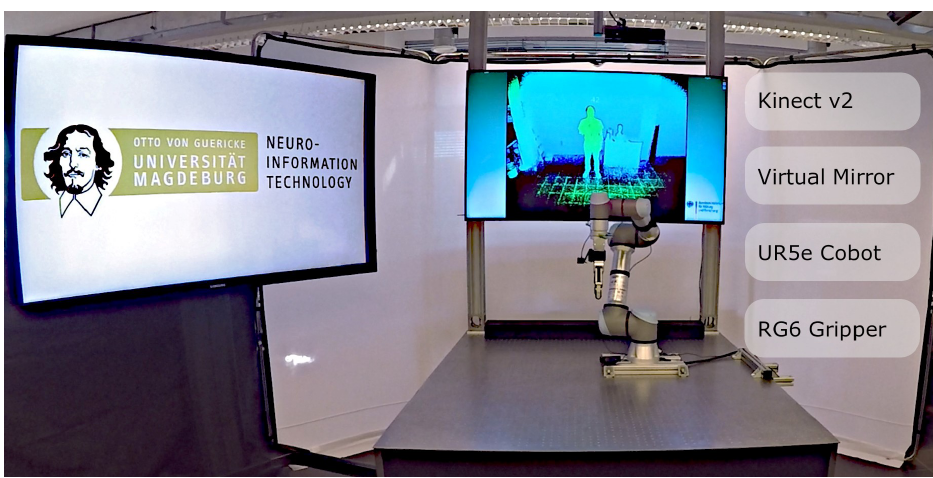
Figure 2. Experimental